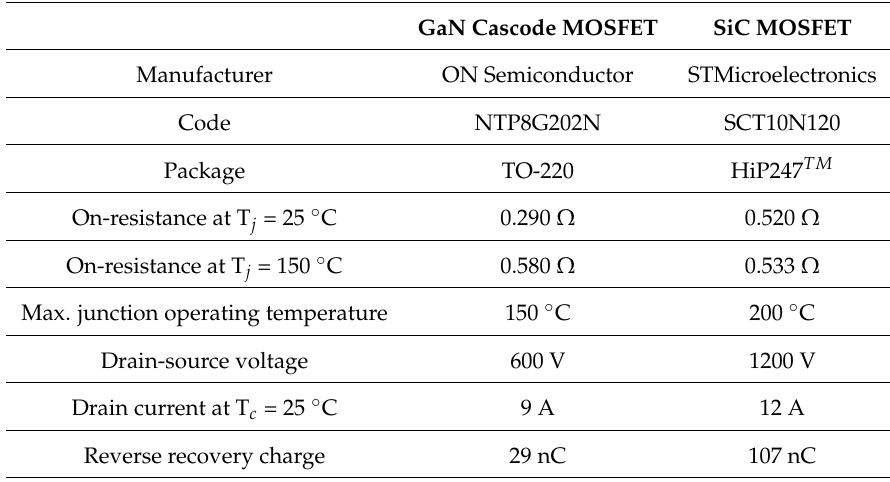
Table 2. The wide-bandgap devices used in the photovoltaic full-bridge inverter together with their key